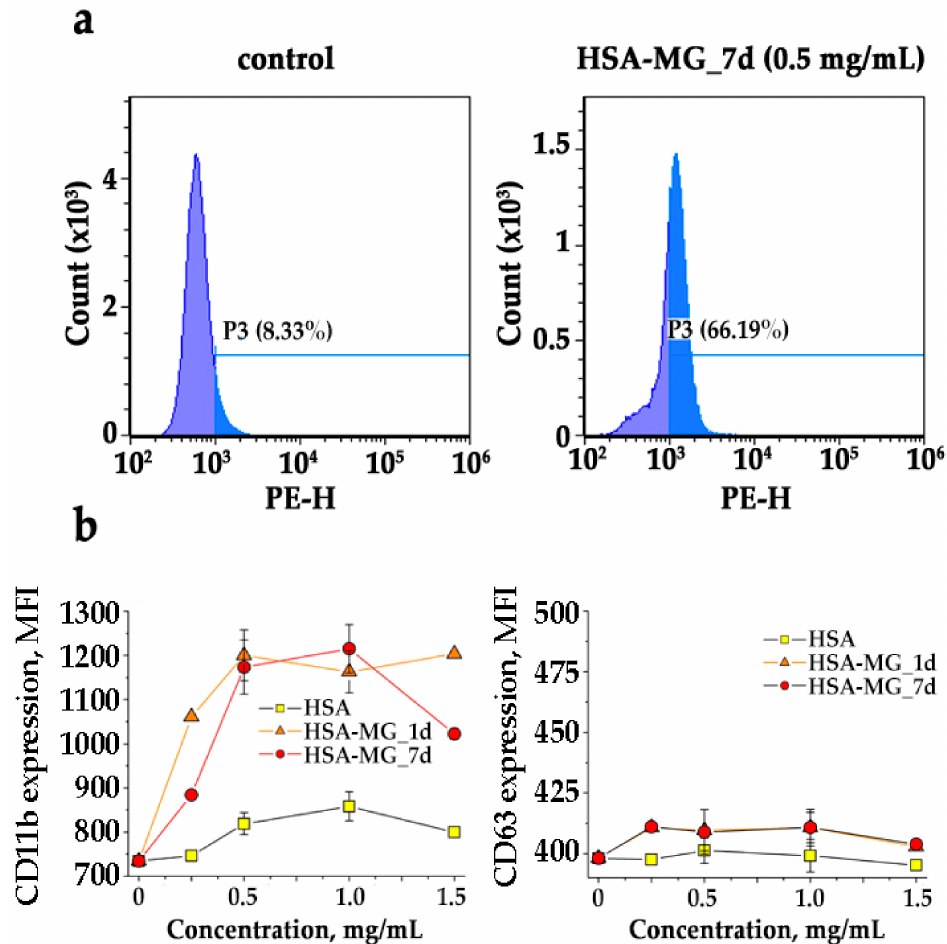
Figure 8. The effect of HSA-MG on neutrophil degranulation. ( a ) Histogram of fluorescence intensity of CD11b-PE bound to neutrophils in the absence (control) and presence of HSA-MG (0.5 mg/mL) (for PE fluorescence excitation—488 nm, emission—585 ± 42 nm). Data are shown for one of three independent experiments. ( b ) Expression of CD11b (marker of PNGs, left) and CD63 (marker of AGs, right) on plasma membrane of neutrophils incubated with native HSA, HSA-MG_1d (HSA was incubated with MG ap to 24 h) and HSA-MG_7d (HSA was incubated with MG ap to 7 days) in different concentrations. For APC fluorescence, excitation was 638 nm, emission was 660 ± 10 nm. Experiments were carried out in Ca 2+ -containing PBS, and at least 20,000 neutrophils were analyzed in each sample. Results are expressed in mean fluorescence intensity (MFI) ± SEM of at least three independent